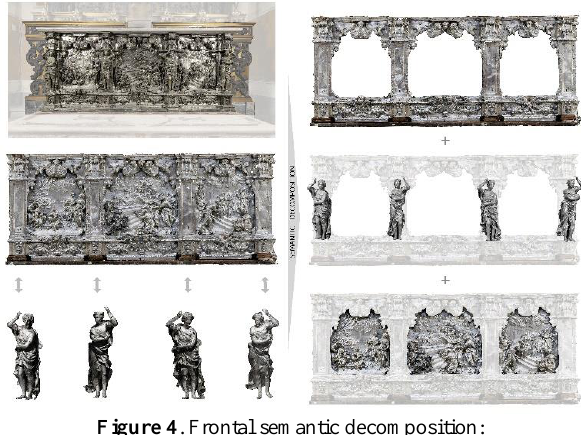
Figure 4 . Frontal semantic decomposition: structure, scenes and caryatids.